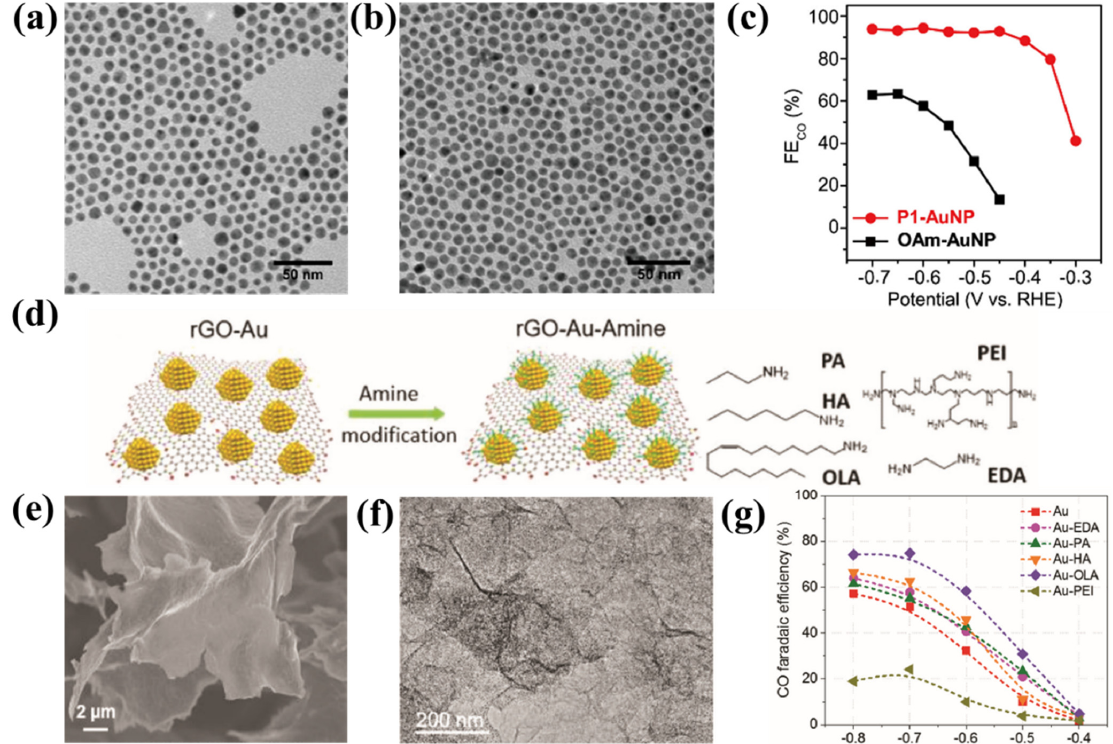
Figure 9. ( a , b ) TEM image of OAM-AuNP and P1-AuNP. ( c ) FEs of CO produced by OAM-AuNP and P1-AuNP electrodes. Reprinted with permission from Ref. [113]. Copyright 2018, Wiley-VCH Verlag Gmbh. ( d ) Schematic illustration of amine modification on the rGO-Au composite. ( e , f ) SEM and TEM image of rGO-Au. ( g ) FE CO and j co at various potentials for rGO-Au and Au-amine catalysts. Reproduced with permission from Ref. [105]. Copyright 2018, Wiley-VCH.